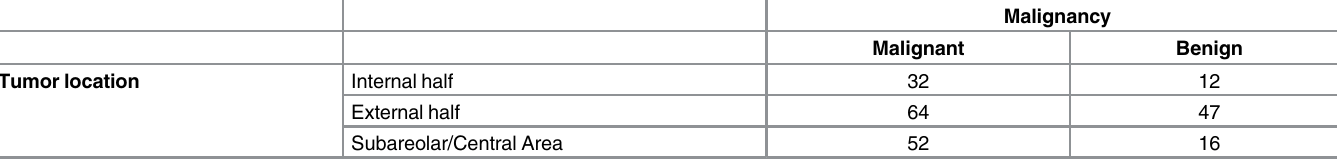
Table 3. Tumor location and malignancy. Table entries: number of lesions.